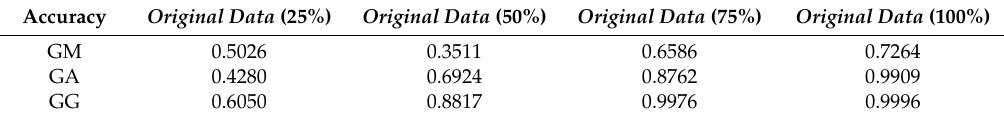
Table 3. The accuracy of RUL prognostics with the kurtosis